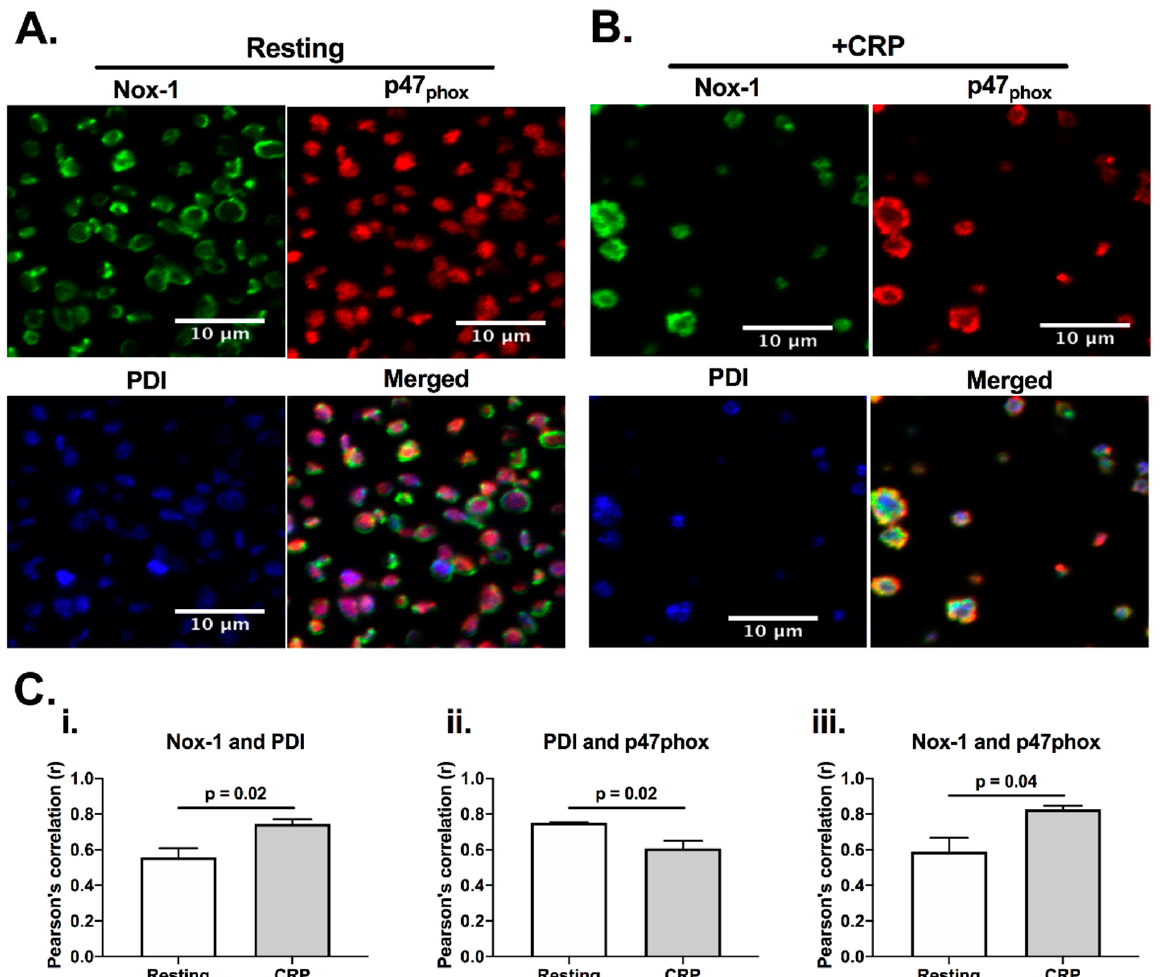
Figure 1. PDI and Nox-1 cellular localization in resting and CRP-activated platelets. Immunofluorescence of platelet-rich plasma (PRP) not stimulated (resting) ( A ) or stimulated with 1 µ g/mL CRP ( B ) for 3 min in the presence of 4 µ g/mL integrilin. ( C ) Pearson’s correlation of at least 3 different fields for 3 independent experiments represents the degree of co-localization of Nox-1 and PDI ( i ), PDI and p47phox ( ii ) and Nox-1 and p47phox ( iii ). Bar graphs show mean ± SEM. Data analysed by paired Student t -test. Exact p -value are presented in each bar graph. Pink colour is the colocalisation of p47phox (red) and PDI (blue), yellow is the colocalisation of p47phox and Nox-1 (green) and white is the colocalisation of all three proteins.